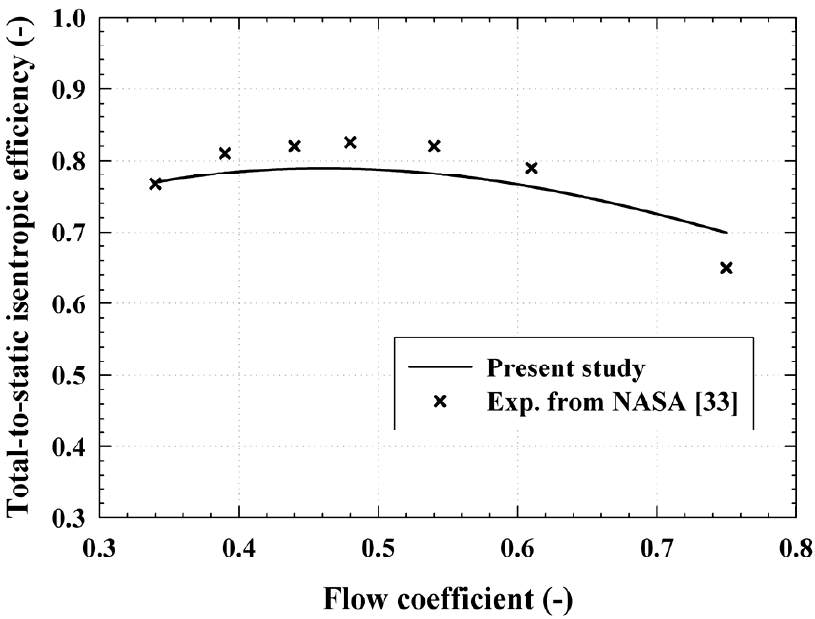
Figure 5. Comparison of the mean-line design results investigated in the present study and previously reported experimental results [33].